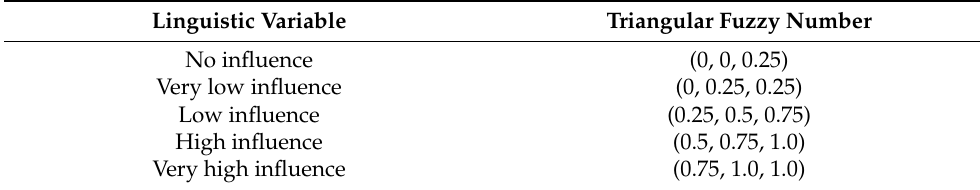
Table 2. Linguistic Variables and Corresponding Triangular Fuzzy